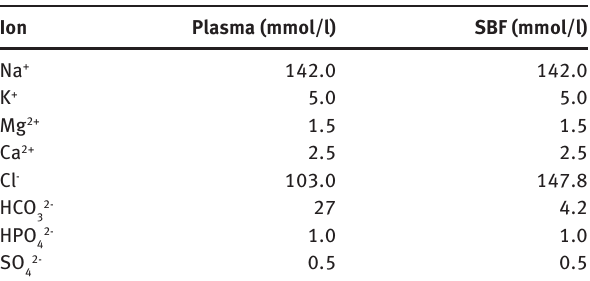
Table 1 Composition of SBF and the inorganic part of human blood plasma